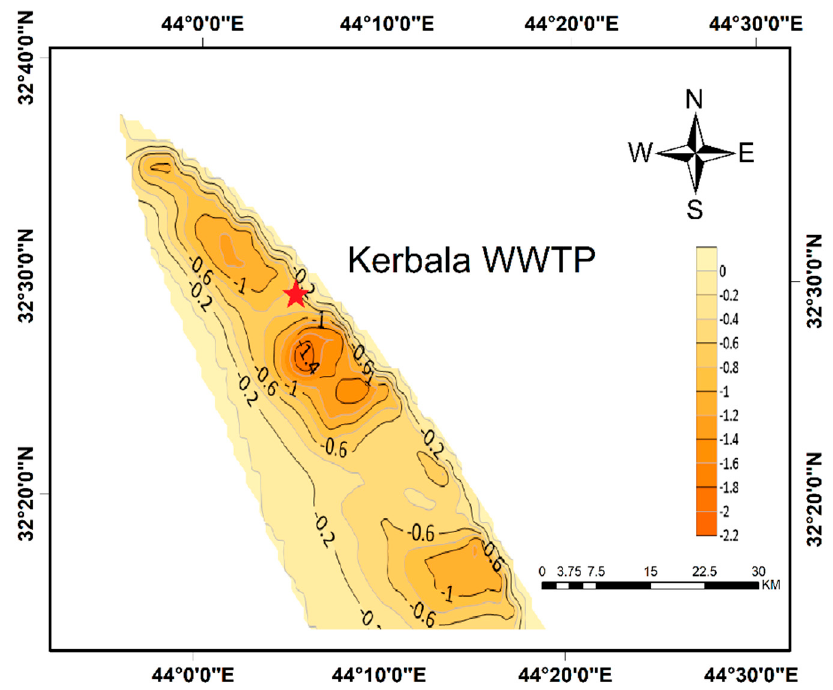
Figure 6. The predicted groundwater elevation drops in 2030 over the study area without the use of artificial recharge.